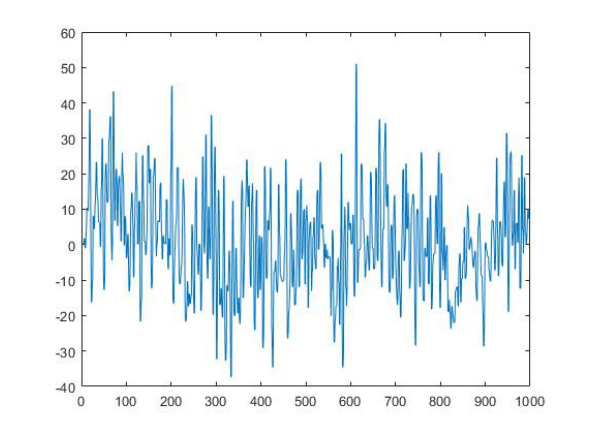
Figure 13. chb03-03 Median Filter Output